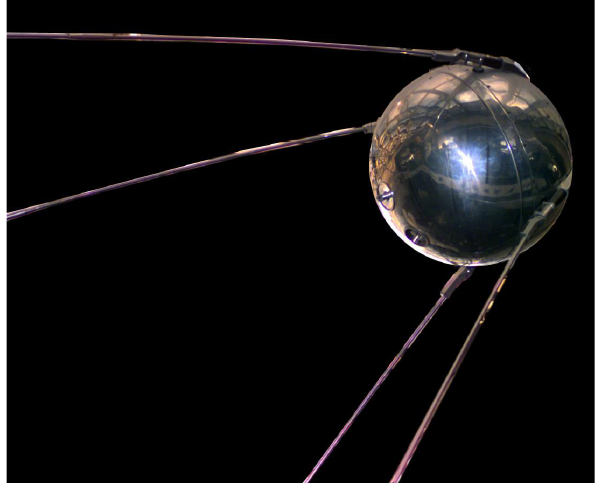
Figure 2. Sputnik I. Courtesy of NASA.